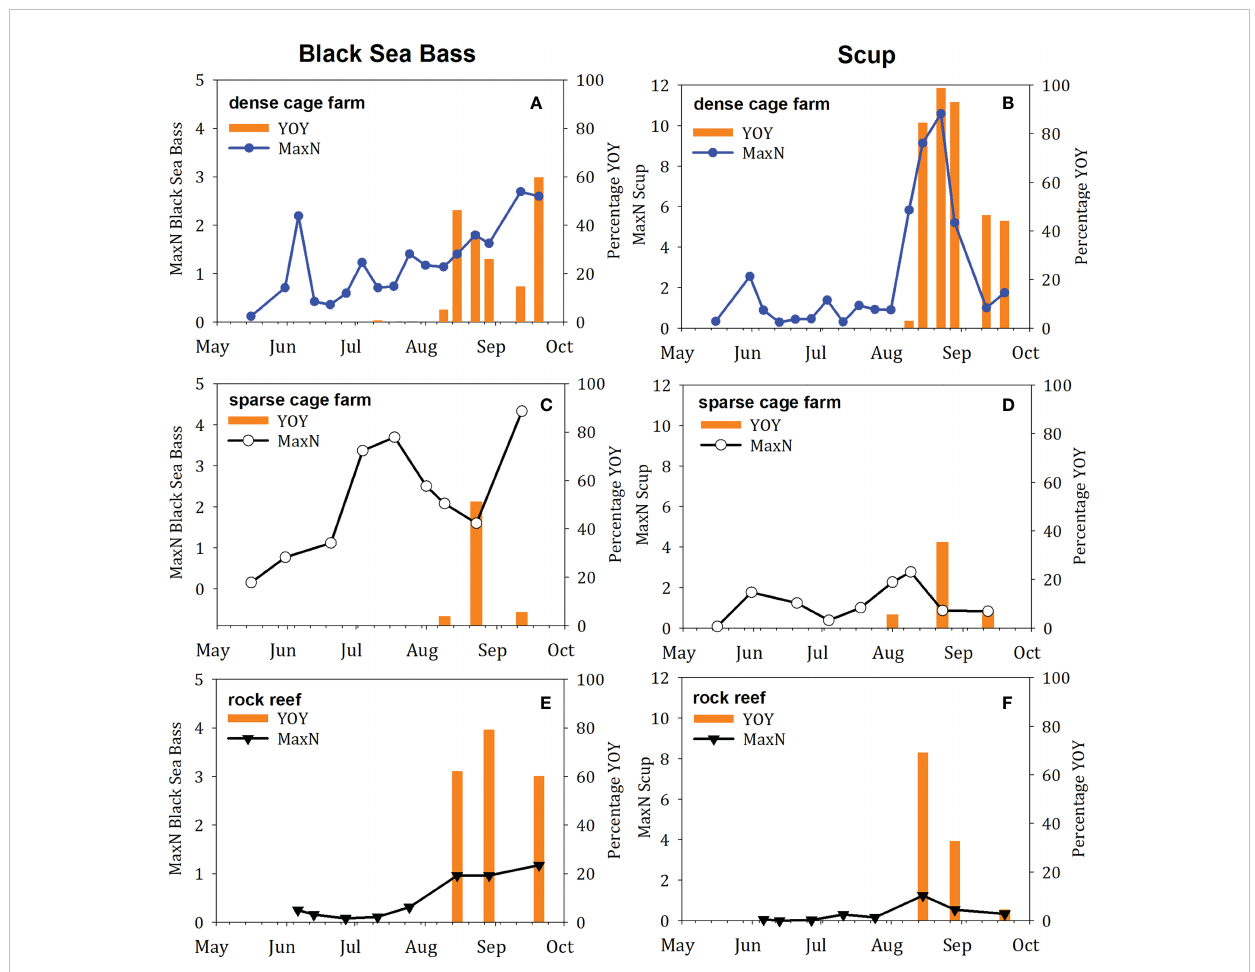
FIGURE 4 Time series of fi sh abundance and proportion of fi sh observed that were young-of-year (YOY) in 2018, for the two species with high relative abundance of YOY. In each fi gure, the MaxN abundance is indicated by the line and scatter plot, and the proportion of that abundance that was YOY is indicated by the orange bars. Species included (A, C, E) Black sea bass, (B, D, F) Scup. Sites included (A, B) dense cage farm, (C, D) sparse cage farm, (E, F) rock